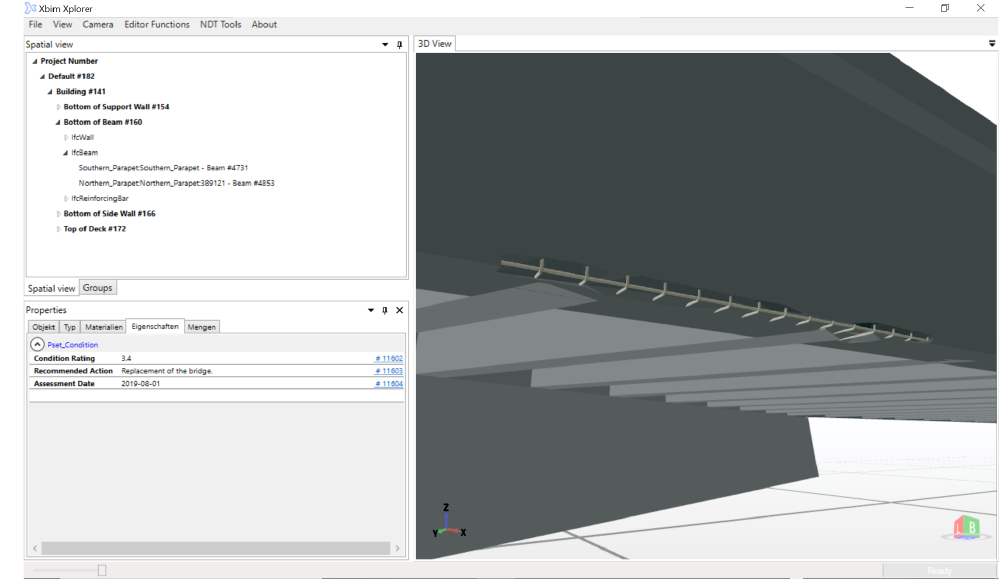
Figure 17. Screenshot from the BIM software xBIM Xplorer [62] with the hierarchy, properties, and 3D